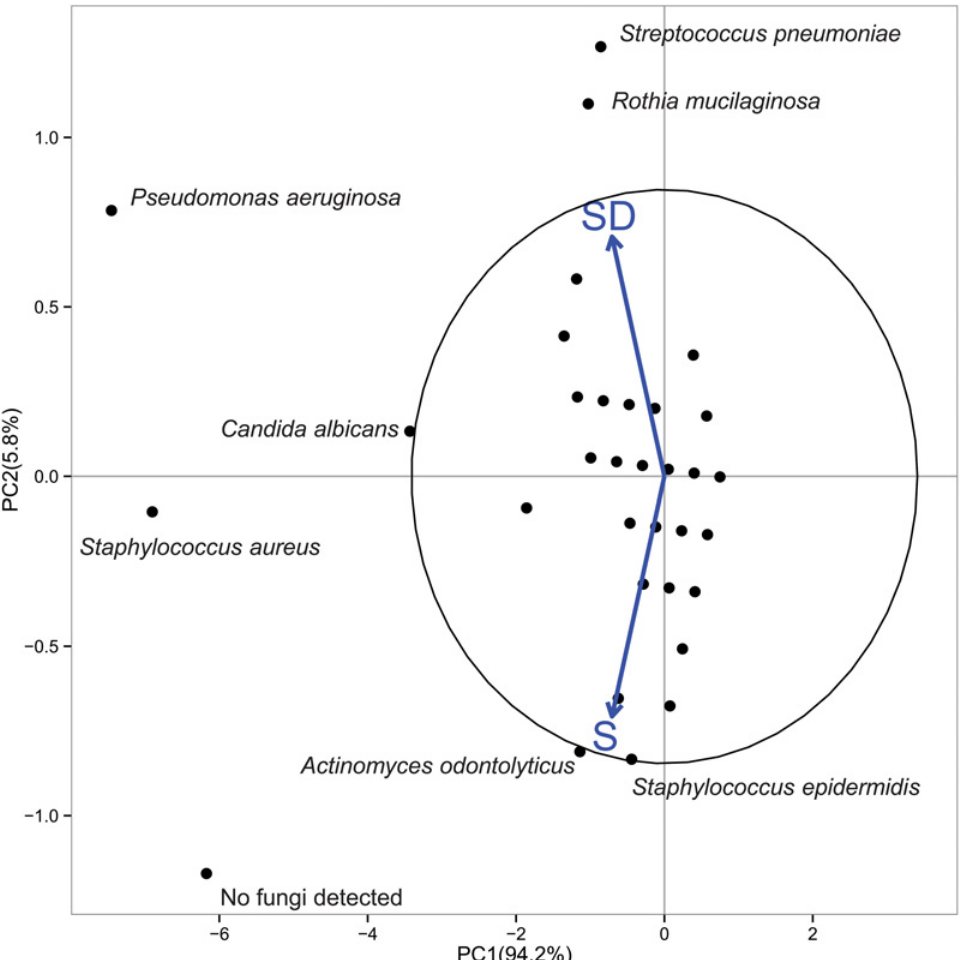
Fig 1. Biplot of the principal component analysis of culturable taxa from S and SD patients. Ellipse with 95% is reported. The numbers on the axes indicate the amount of variance explained by each component. The labels outside the 95% ellipse have been jittered to avoid overlaps. Black circles represent culturable taxa. Are indicated those taxa, ouside the ellipse, that are significantly associated to the PC1 and PC2.